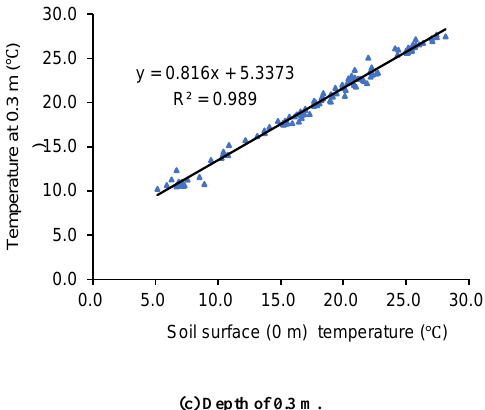
(c) Depth of 0.3 m. Figure 4. Linear regression and coe ffi cient of determination of the daily average greenhouse soil Figure 4. Linear regression and coefficient of determination of the daily average greenhouse soil temperatures of soil surface (0 m) and di ff erent depths. temperatures of soil surface (0 m) and different depths